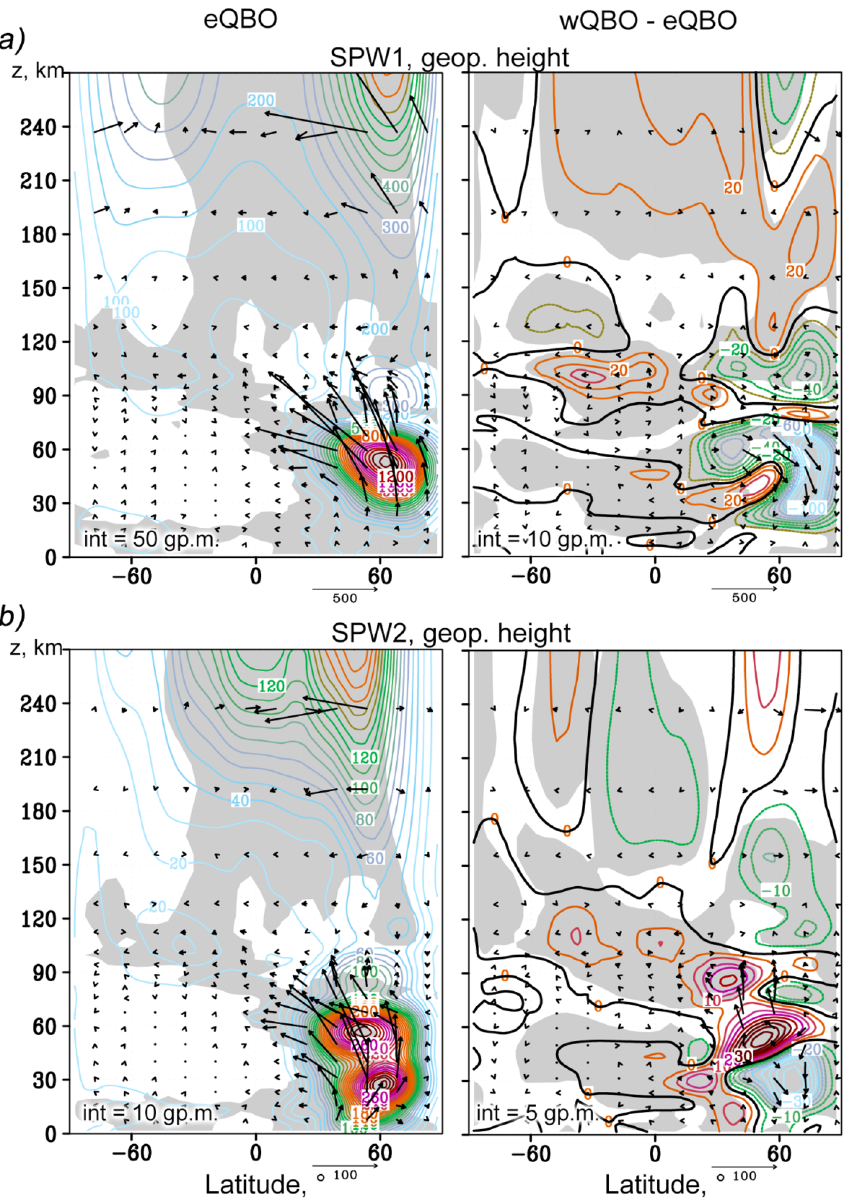
Figure 2. Amplitudes of the geopotential height variations caused by SPW1 and SPW2 in gp. m. ( a and b , left, respectively) for the MUAM ensemble for January–February, eQBO; respective amplitude increments due to change from wQBO to eQBO (right). Arrows show EP flux (left) and its increments (right) in e z/70 m 2 /s 2 (vertical component is multiplied by 200). Gray background shows waveguide (left) and 95% statistical significance (right). Intervals between contours are indicated in the left bottom corner of each